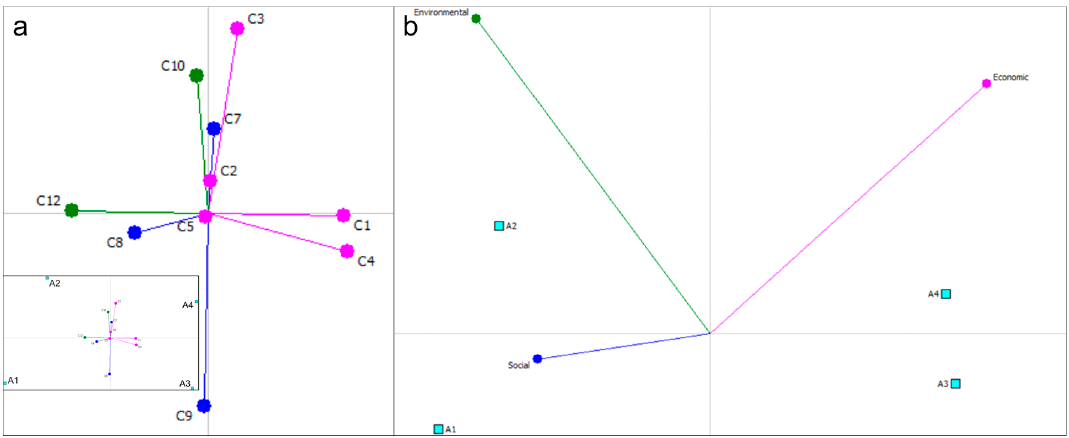
Figure 9. The GAIA plane with ( a ) the criteria; ( b ) the groups of criteria.